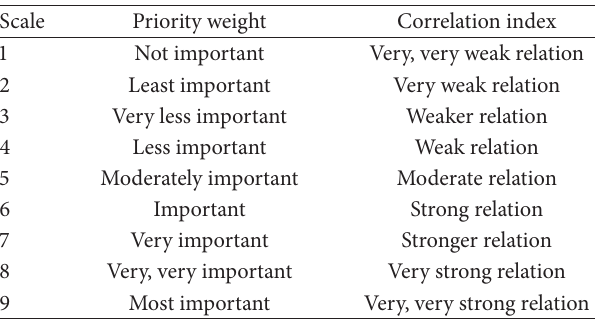
Table 2: Scale indicating priority weight and correlation